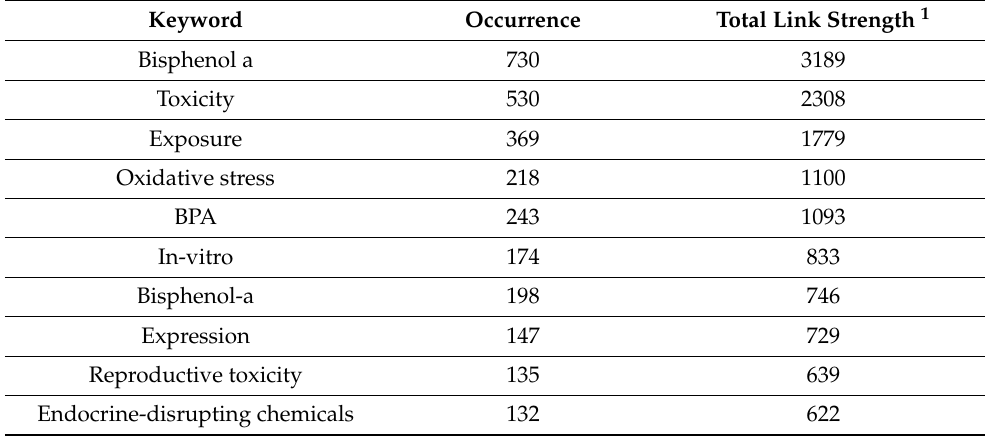
Figure 6. Overlay visualization of co-occurrence keywords for “BPA toxicity”. Table 5. The top 10 co-occurrence keywords for “BPA